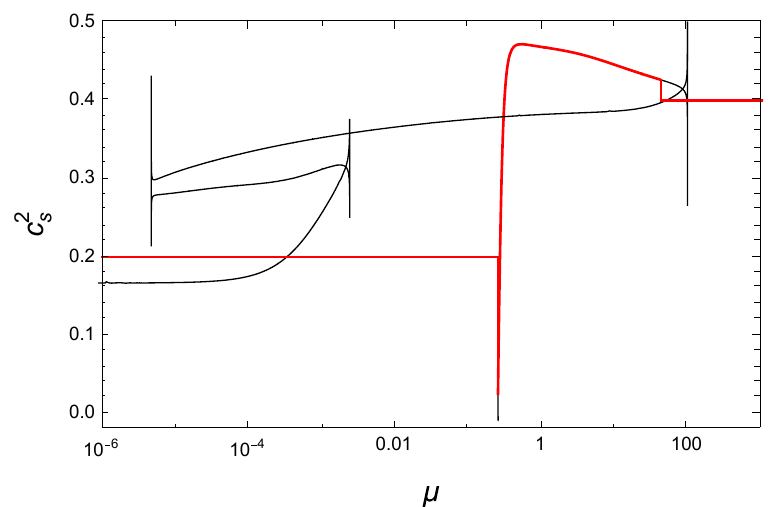
Figure 5 . Speed of sound squared c 2 in units of the speed of light as a function of the dimensionless s quark chemical potential (cid:22) , computed with the parameters (2.41). The thick (red) curve shows the result for the stable phase, from the mesonic phase at low (cid:22) through the nuclear matter phase at intermediate (cid:22) to the quark matter phase at large (cid:22) . The thin (black) curve corresponds to metastable and unstable